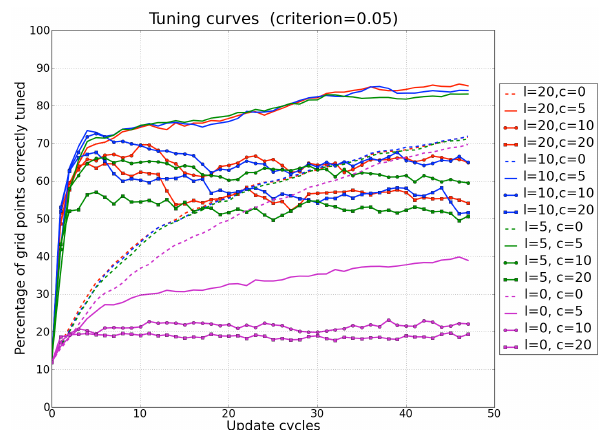
Figure 4 : Yellow color points show the (correctly) tuned grid points. The white or clear grid points show the untuned points. The (correctly) tuned point lies within 0.05 absolute units of the perfect value at a given grid point. The blue colored contours enclose areas with strong friction velocity ( Figure 1b) . The red contours enclose areas with high erodibility (Figure 1a). (a) Shows the quality of tuning for the tuning experiment corresponding to Figure 1e. (b) Shows the quality of tuning for the tuning experiment corresponding to Figure 1i.